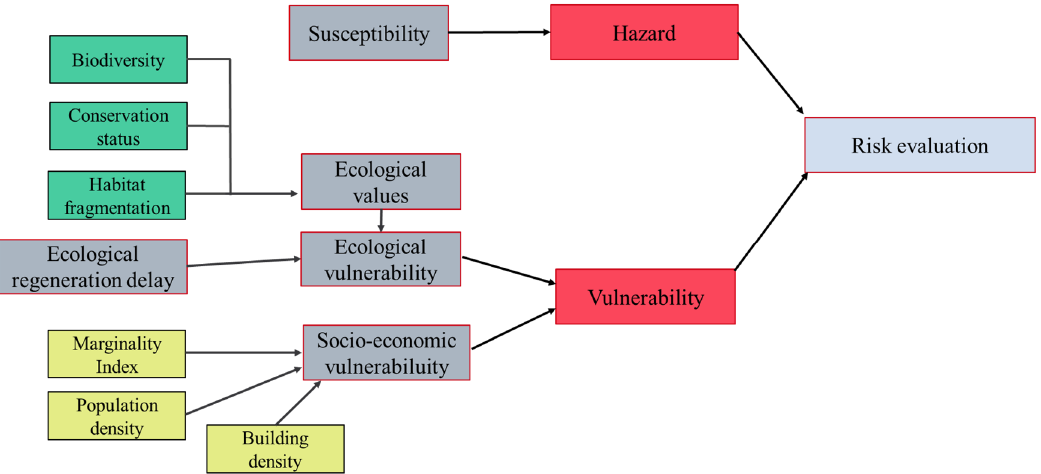
Figure 1. Components of landslide risk assessment.